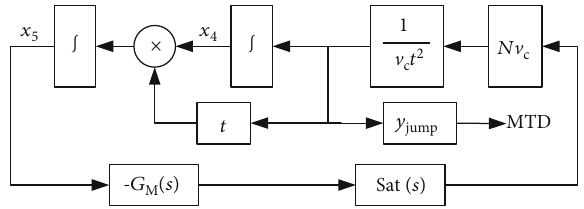
Figure 10: Block diagram of the analytic derivative adjoint model.